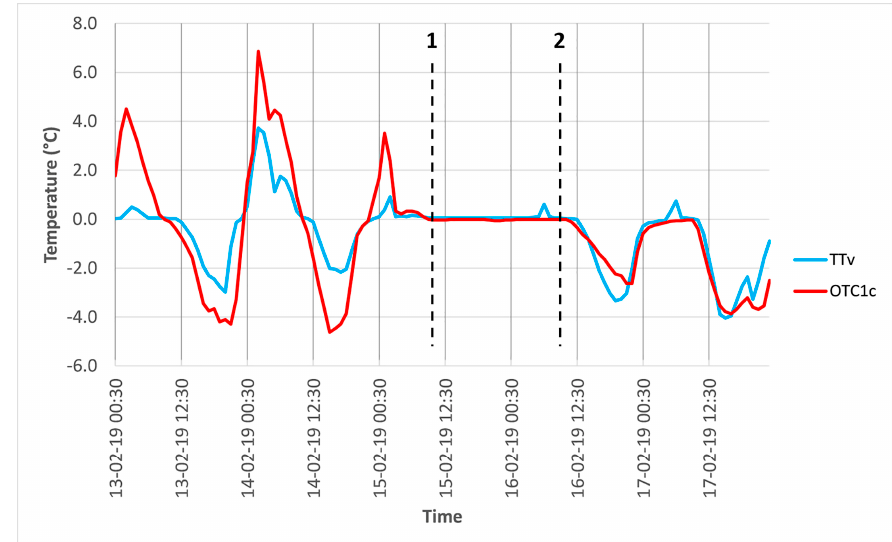
Figure 6. Ground surface temperature patterns between 13 and 18 February 2019 at the EPNB. The thermistors are all located at 2 cm of depth at different manipulation experiments (TTv = shallower side of a precipitation shield, OTC1c = exterior of an open-top chamber). 1 = beginning of the inundation, 2 = end of inundation according to the thermistors.